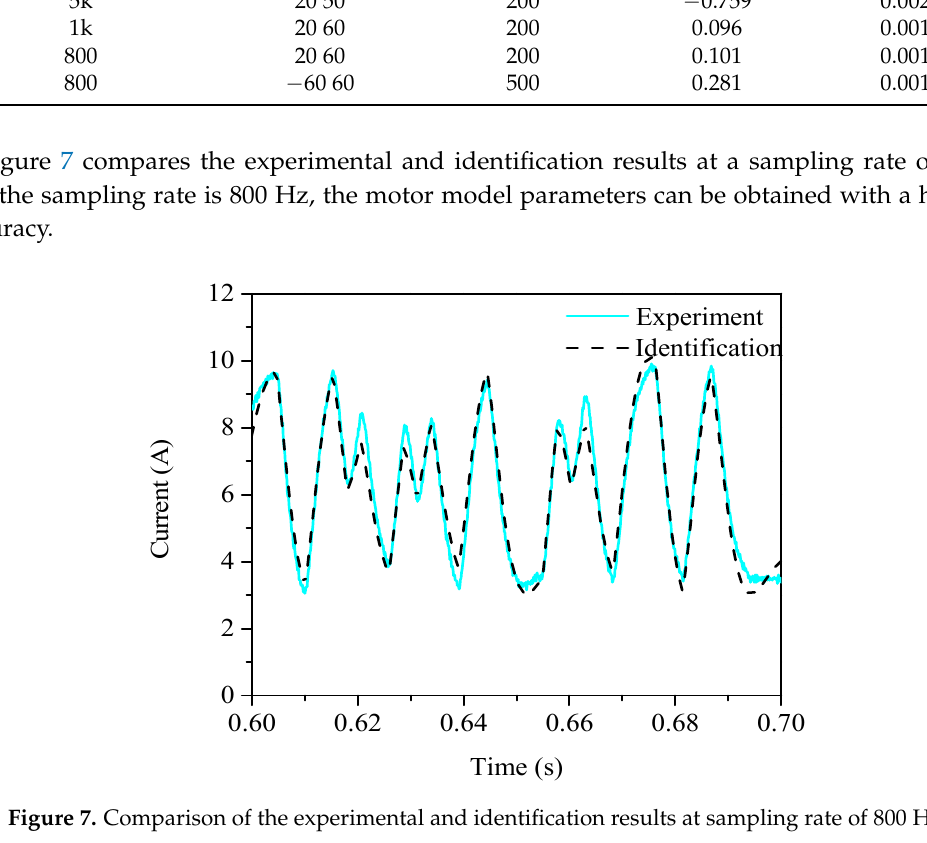
Table 4. RT2 and YIC under different identification conditions. Identification Results